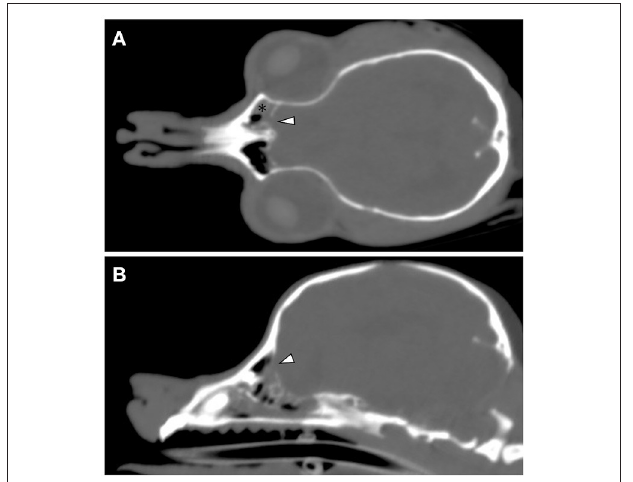
FIGURE 2 | Cranial CT images of a 12-year-old Yorkshire terrier with epileptic seizures and nasal discharge (A,B) . On the coronal and sagittal bone condition images at the cribriform plate level ( A,B , respectively), a defect of the left cribriform plate is noticeable (white arrowheads). On the coronal soft tissue images at the level of the optic nerve (A) , an irregular lesion in the left nasal cavity around the left cribriform plate is observed (black asterisk).